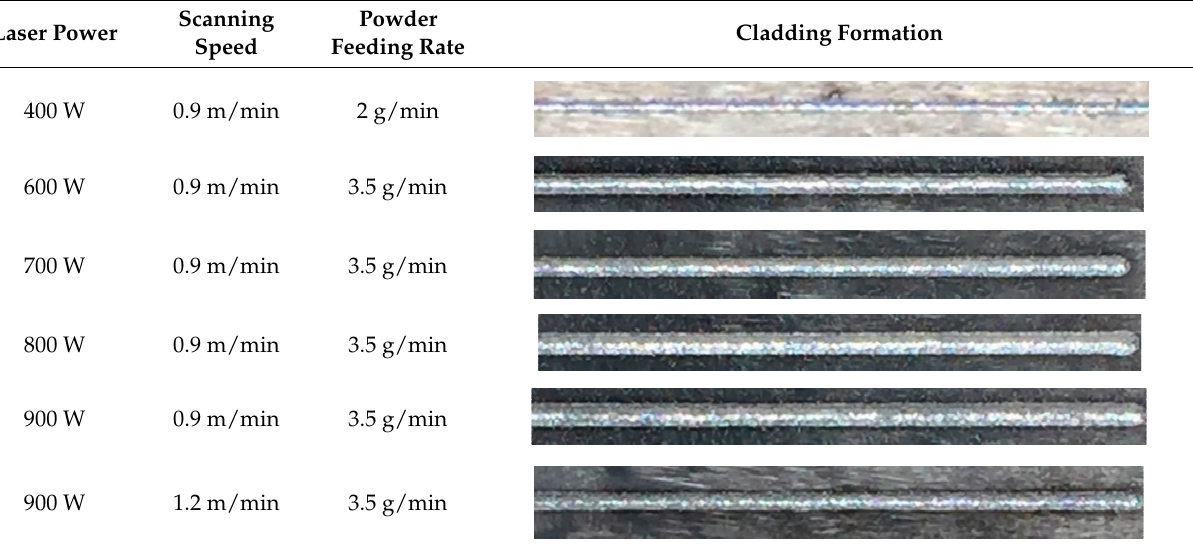
Table 4. Repairing formation in single pass under laser spot diameter of 1.0 mm.